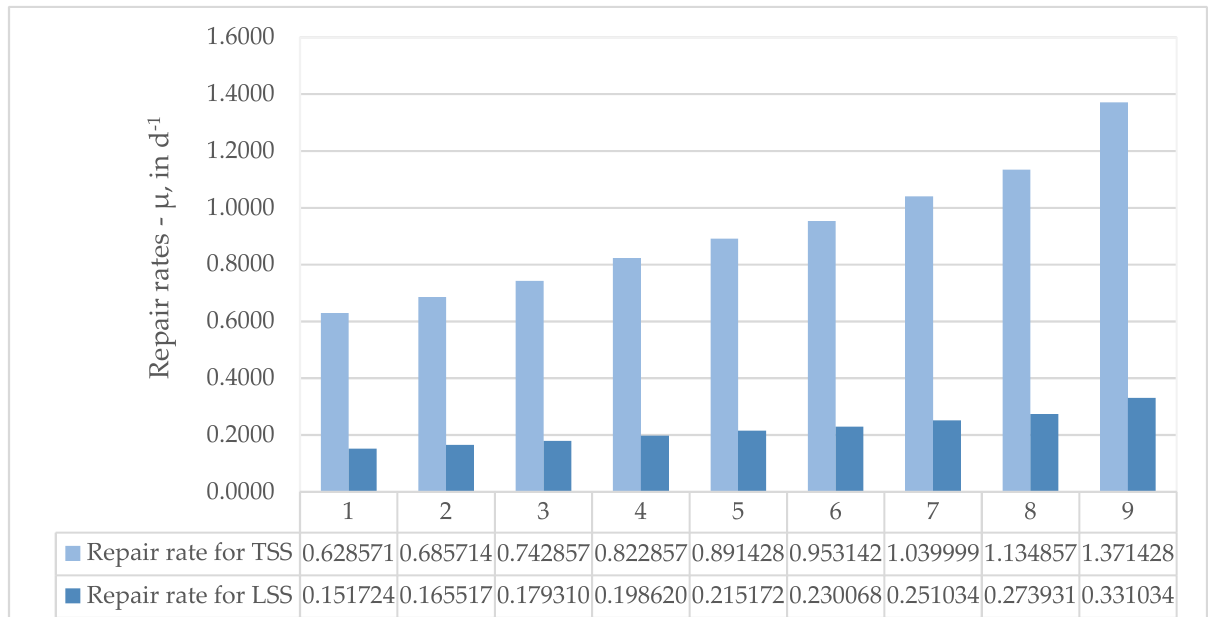
Figure 5. Dependence of the P LSS values on the failure rates λ CSS, λ TSS, and λ LSS acc. to Figure 2, for the constant µ TSS = 1.0399 d −1 and µ LSS = 0.0276 d −1 .